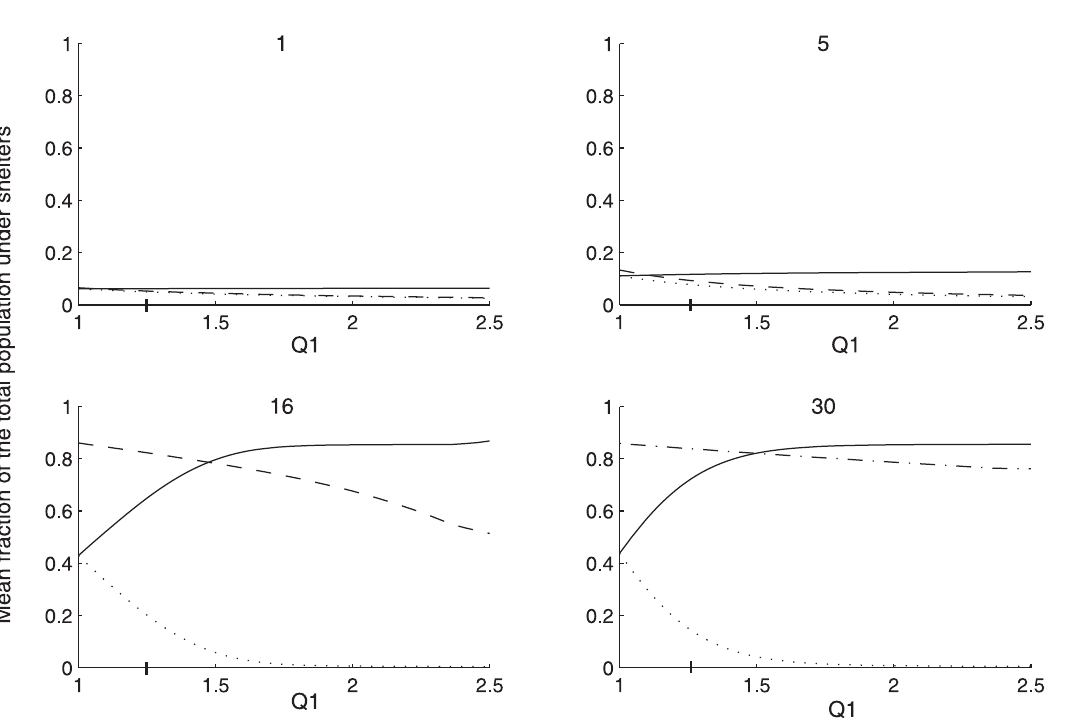
Figure 4. Theoretical results. Comparison between theoretical fractions of individuals settled in a binary choice (a dark shelter (solid line) and a light one (dotted line)) and in a no choice setup (corresponding to the light shelter (dashed line)) according to Q 1 . Vertical bars on x-axis represent the experimental Q 1 .